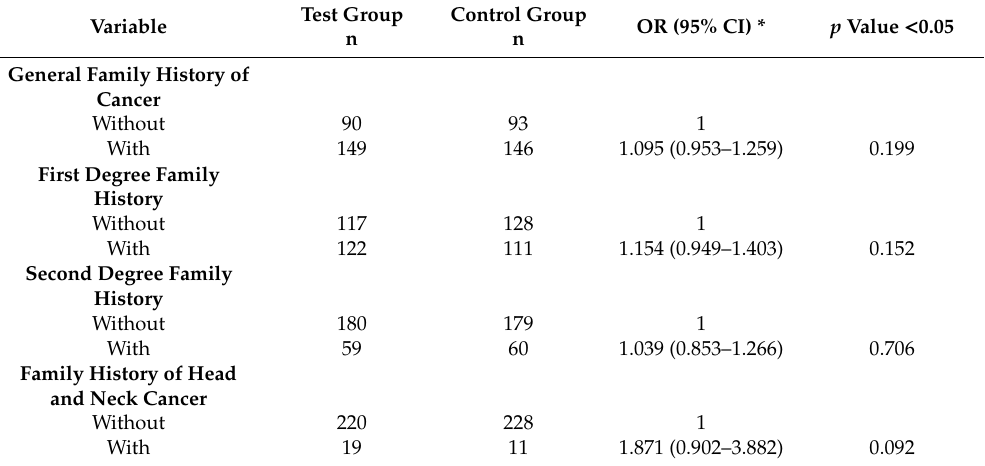
Table 5. Odd Ratios (ORs) for Family History of